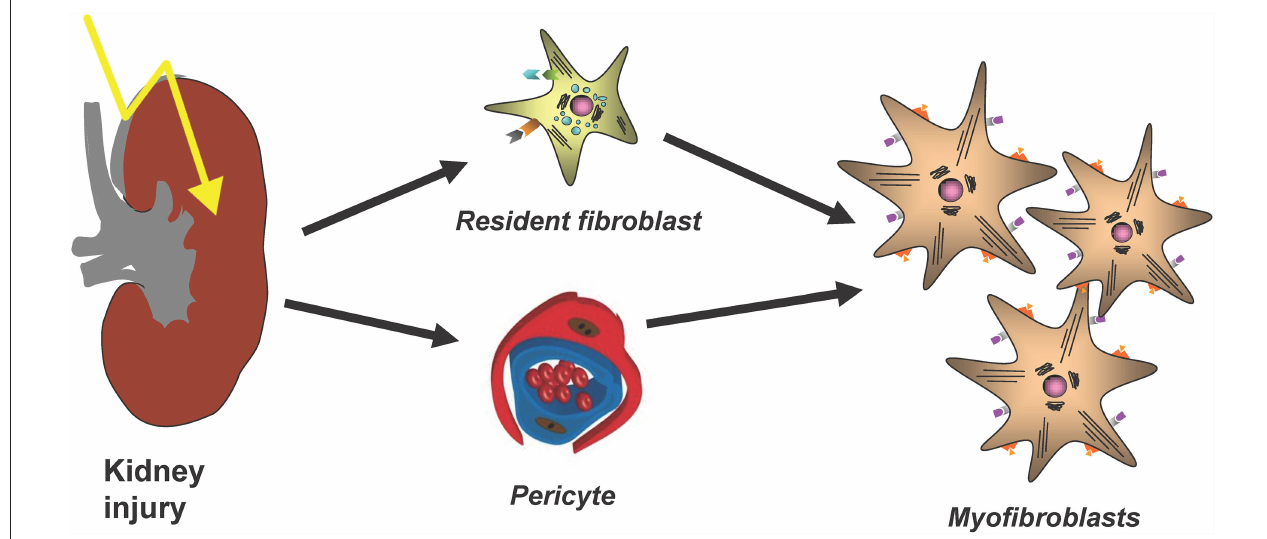
FIGURE 1 | The main cellular source of kidney myofibroblasts following kidney injury and fibrosis progression are resident renal fibroblasts and pericytes.